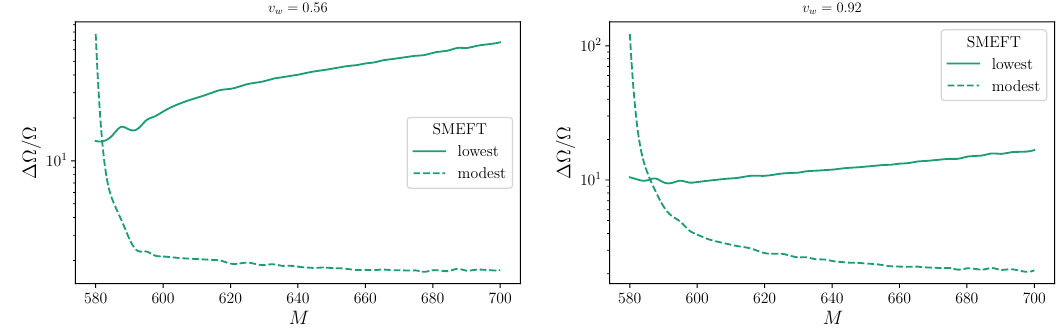
Figure 6 . SMEFT : the relative error when using the lowest and modest levels of diligence, com- pared to the highest level of diligence (for which ∆Ω / Ω = 0 ). The vertical axis shows the peak (frequency-independent) gravitational wave energy density for detonation. The precise definition of ∆Ω / Ω is given in eq. (4.1). The horizontal axis corresponds to the cutoff scale M . ∆Ω / Ω is dis- played for deflagration and detonation at different levels of diligence using eq. [(2.7), (2.15), (2.61)] and eq. (4.1). The temperatures are set to T (2.4), T (2.11), and T (2.27) for the lowest, mod- n p f est, and highest diligence respectively. Both the modest and highest diligence contains suppression factors due to the lifetime of the source. The highest diligence contains the suppression factor due to vorticity effects in the